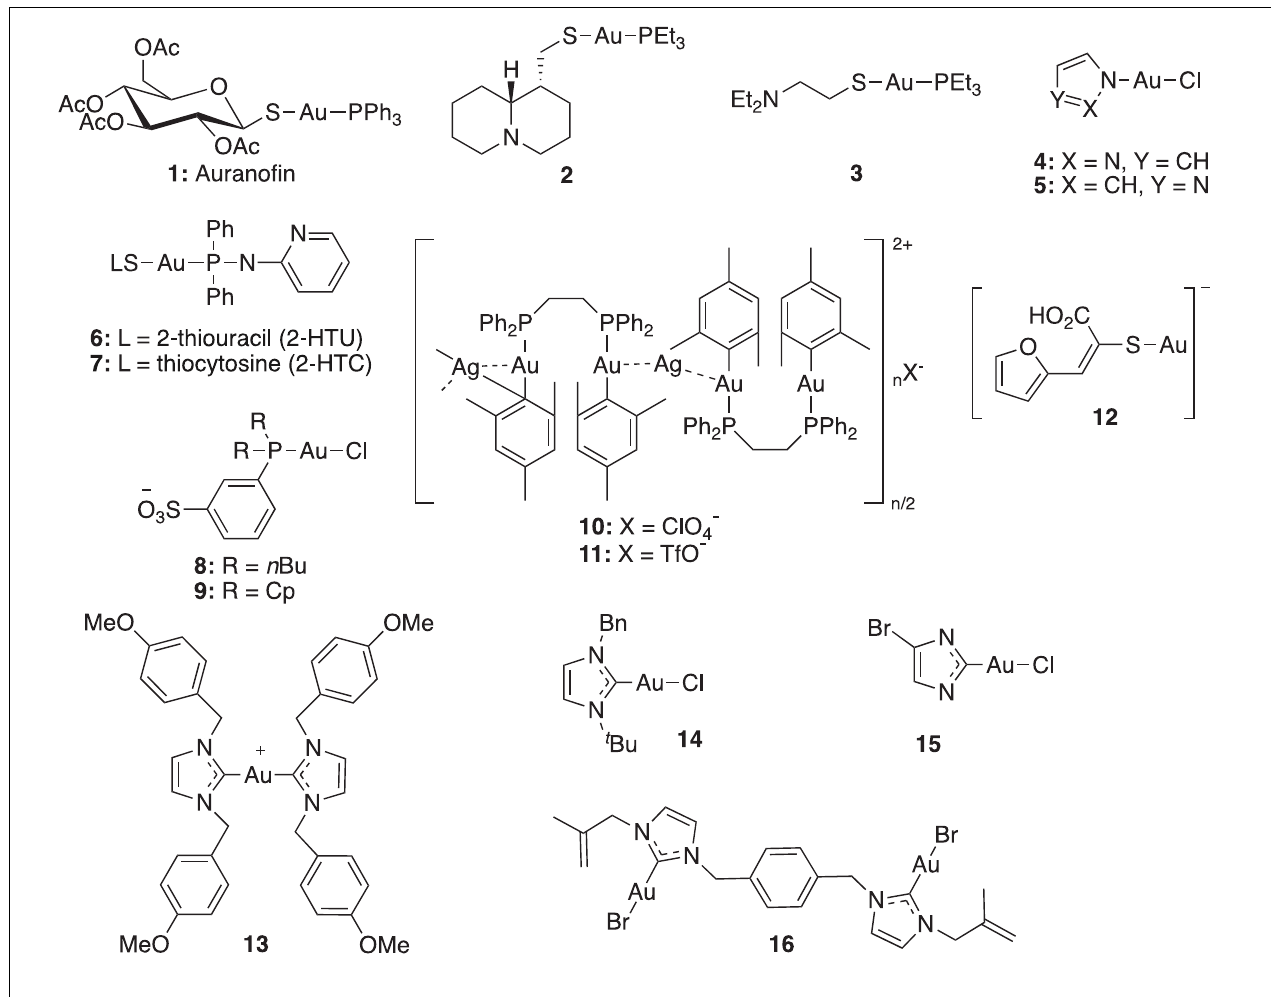
FIGURE 1 | Most representative gold(I) complexes with antimicrobial